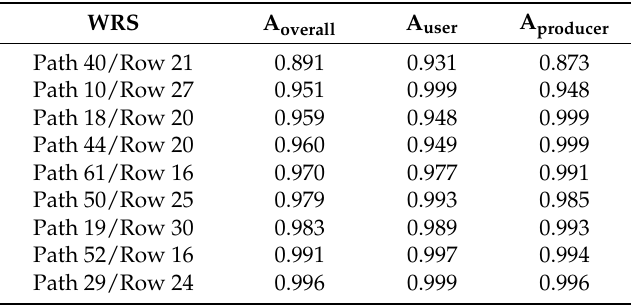
Table 2. Spatial agreement accuracies between the HOT images created with AutoHOT and Manual HOT for nine selected Landsat scenes (sorted by overall accuracies). A overall , A user and A producer are overall, user’s and producer’s accuracies.